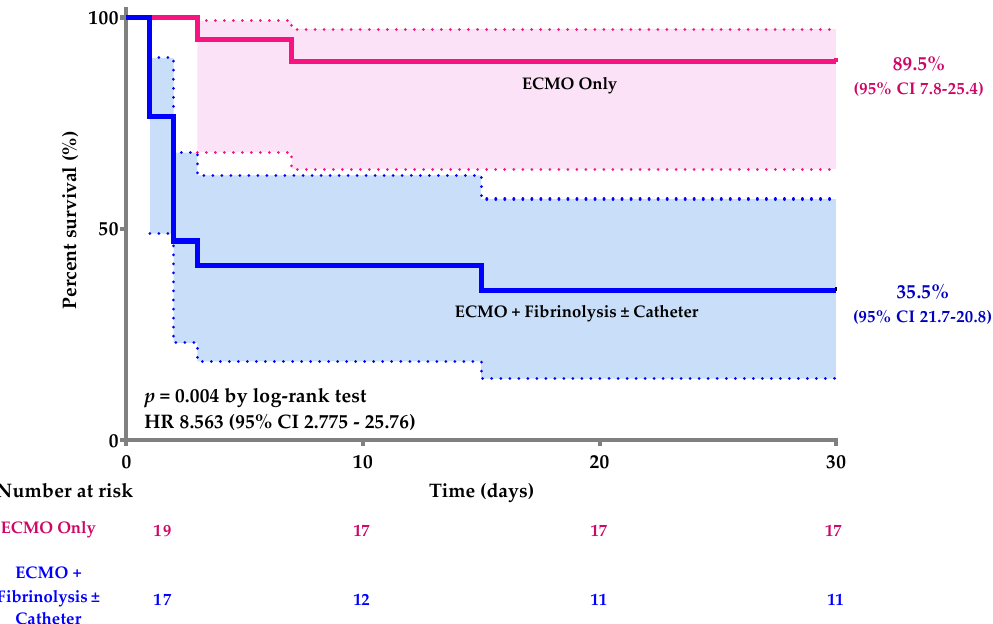
Figure 2. Kaplan–Meier curves for the 30-day survival of patients with MAPE implanted with only an ECMO or treated with fibrinolysis and/or catheter thromboaspiration before ECMO implantation. HR: Hazard Ratio